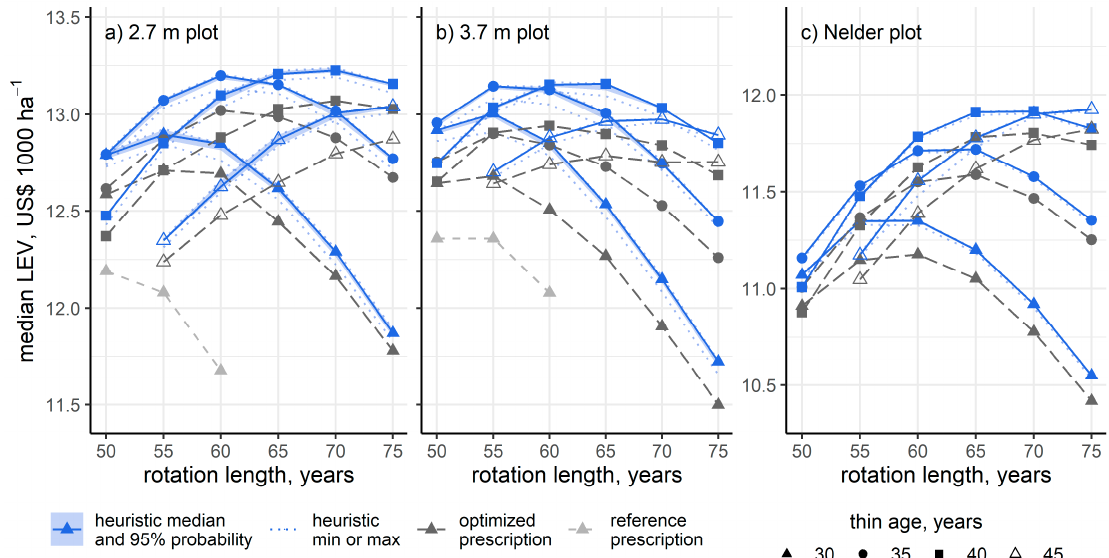
Figure 2. Land expectation values (LEVs) obtained from thinning the three Douglas-fir plots in this study as a function of the method used to create a thinning prescription, a plot’s stand age at the time of thinning, and length of the even age rotation. For heuristics, the median LEV was taken across all eight heuristics to integrate with Figure 3.